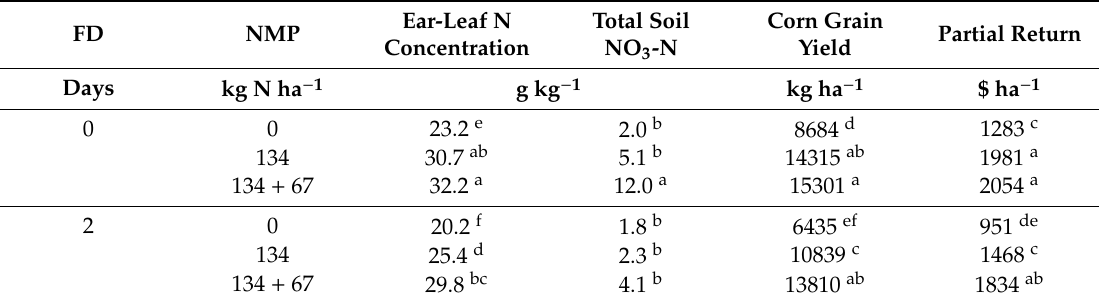
Table 4. Ear-leaf N concentration and total soil nitrate-nitrogen (NO 3 -N) collected at R1, corn grain